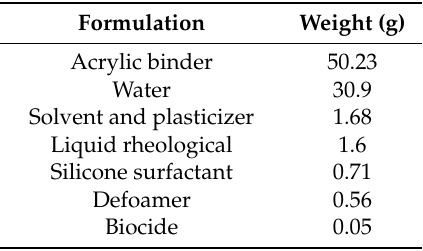
Table 1. Clear coat complete formulation.